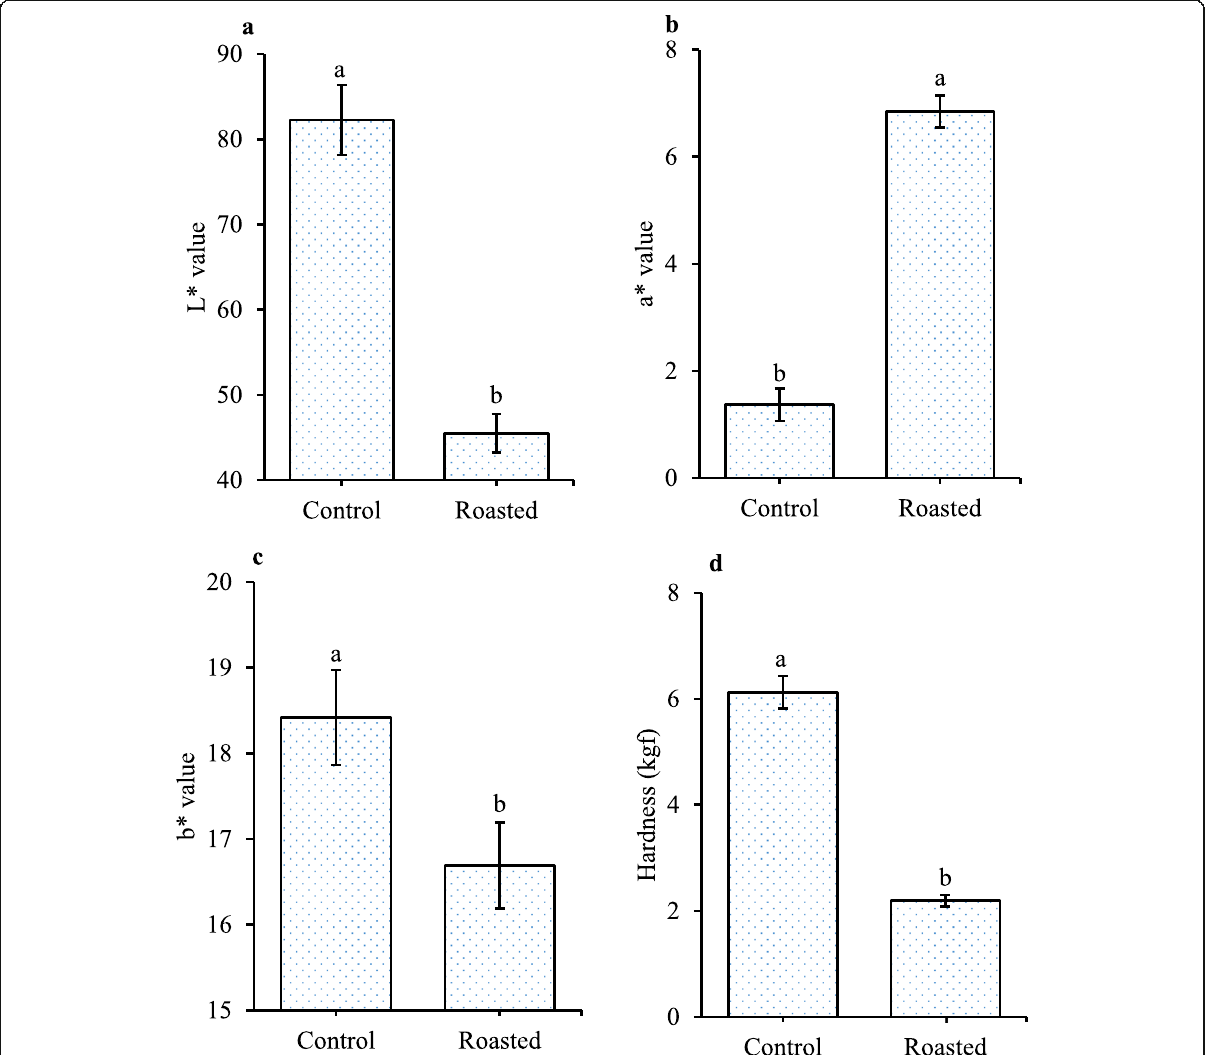
Fig. 3 Evaluation of the impact of roasting on physical characteristics of fox nuts. a) L* value for color, b) a* value for color, c) b* value for color, d) Hardness of nuts. Values are means of 6 replications; error bars stand for standard deviation. Means sharing different letters show significant difference between the variables based on Independent T-test at P ≤